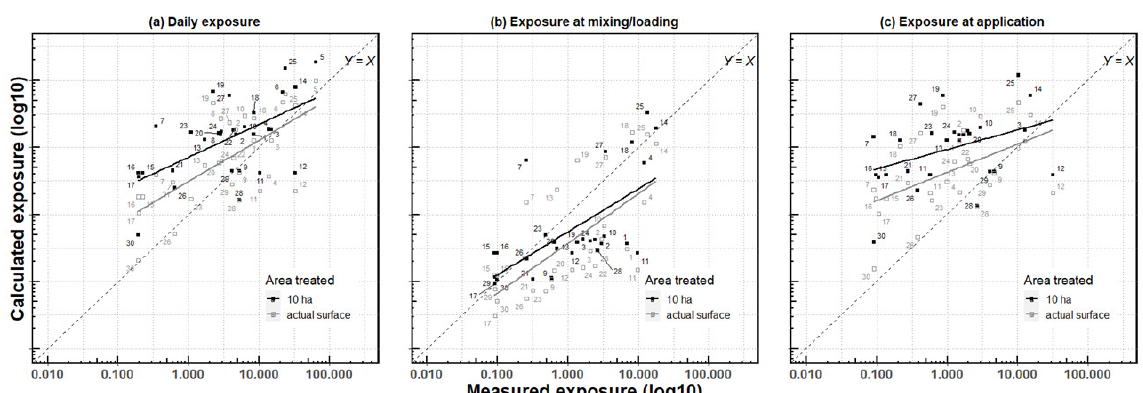
Figure A6. Linear regressions of exposure calculated by the AOEM and measured in the CANEPA field study, after modification of the rates of active substances applied (kg/ha) to obtain actual amount of active substance handled in the observation day.